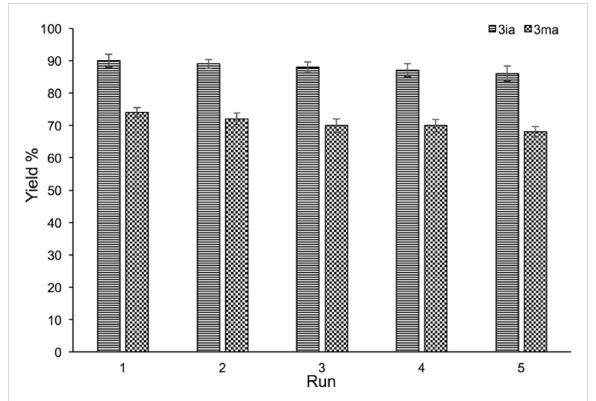
Figure 5: Recycling studies of the Pd/MgAl-LDH catalyst for Heck reactions. Reaction conditions: 1i or 1m (1.5 mmol), 2a (2.1 mmol), Pd/MgAl-LDHs (2.5 mol %), TBAB (1.5 mmol), K 2 CO 3 (3.6 mmol), and silica gel 5 g were placed in a 80 mL stainless-steel vessel ( Φ MB = 0.25, d MB = 5 mm). HSBM conditions: 60 min at 800